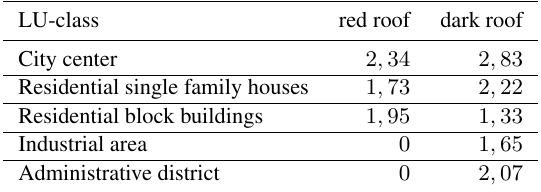
Table 4: Beta index of different roof type